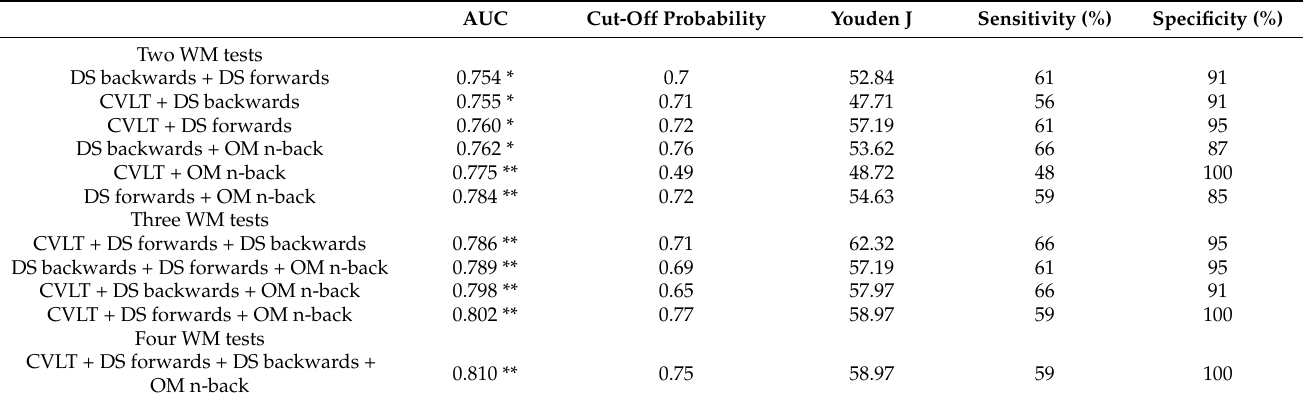
Table 3. Diagnostic accuracy of different WM test combinations.